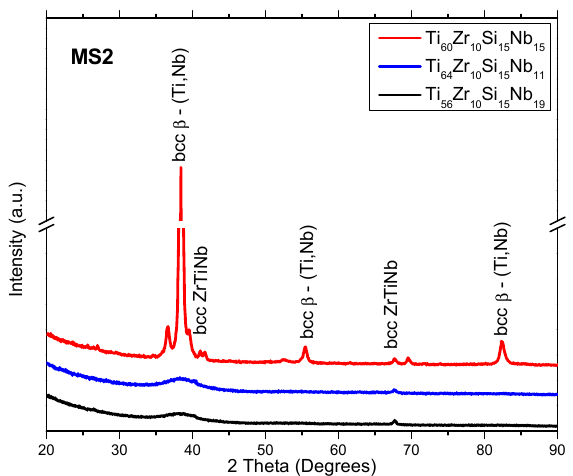
Figure 3. X-ray diffraction patterns of Ti–Zr–Si–Nb alloys obtained with 36 m/s peripheral speed— MS2.